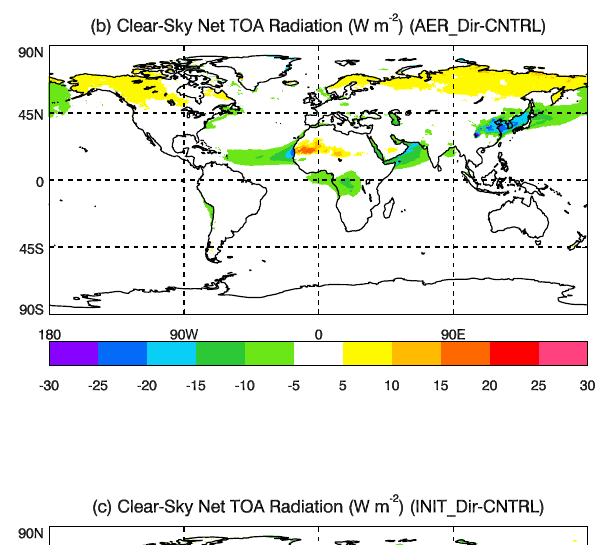
Fig. 9. Direct and indirect impacts of aerosol on the all-sky net TOA radiation at T + 120 from Fig.9. Directandindirectimpactsofaerosolontheall-skynetTOA radiation at T +120 from AER DIR INDIR.